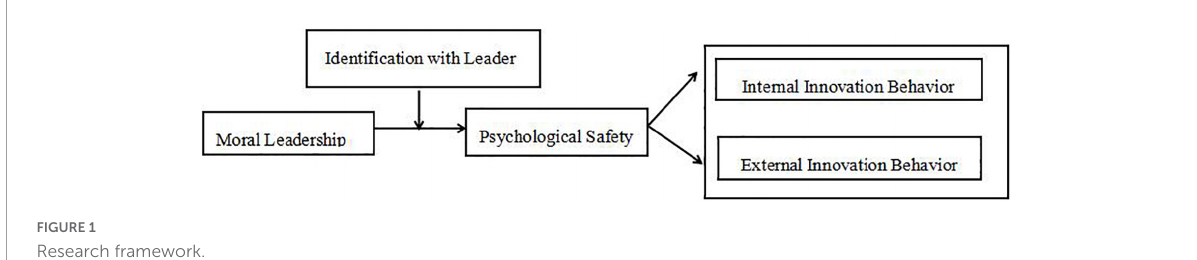
FIGURE1 Research